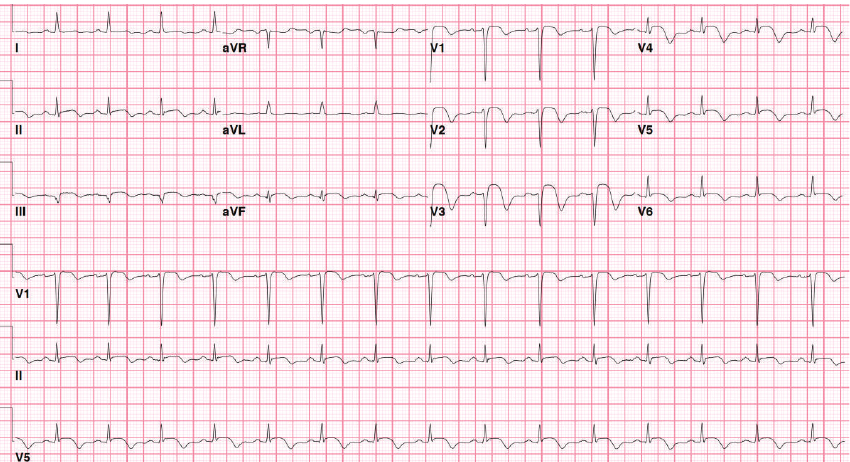
Figure 4: EKG after showing resolution of STE now shows new STE in V3-V4 while the patient was complaining of recurrent CP approximately 15 hours after cardiac catheterization.